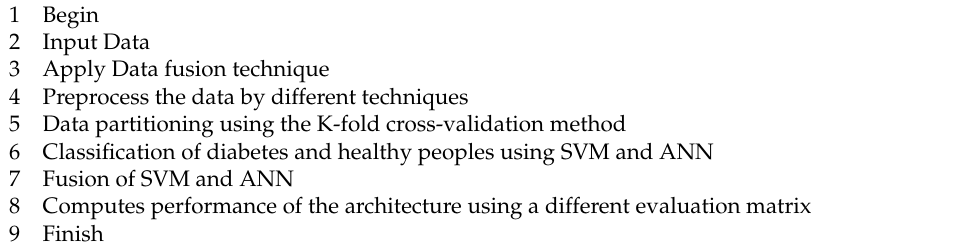
Table 3. Steps for the Implementation of the Proposed